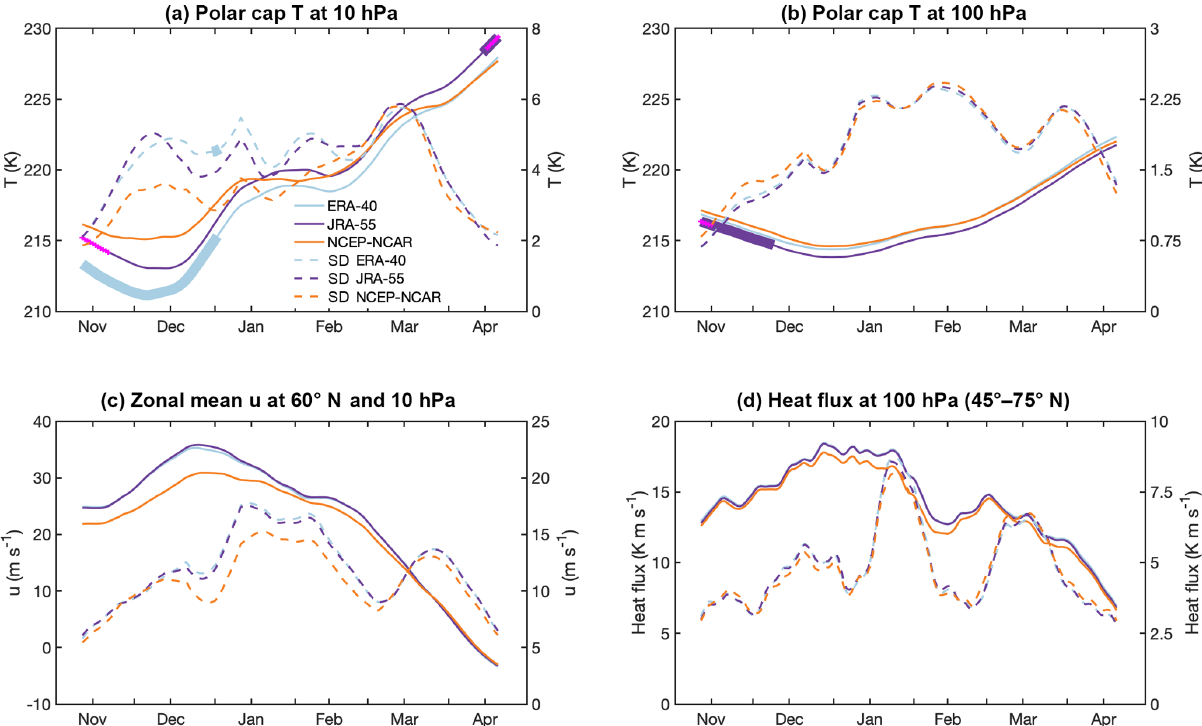
Figure 1. The 21d running mean of the daily climatology (solid lines) and standard deviation (dashed lines) in the historical period (1958– 1978) of (a) polar-cap (50–90 ◦ N) averaged temperature at 10hPa, (b) polar-cap (50–90 ◦ N) averaged temperature at 100hPa, (c) zonal-mean zonal wind at 60 ◦ N and 10hPa, and (d) heat flux at 100hPa averaged over 45–75 ◦ N. The left (right) y axis refers to the mean (standard deviation) in each plot. Thick lines indicate values of ERA-40 or JRA-55 that are significantly different from those of NCEP-NCAR reanalysis at the 95% confidence level. Magenta crosses correspond to JRA-55 values that are significantly different from ERA-40 ones at the 95% confidence level (Student’s t